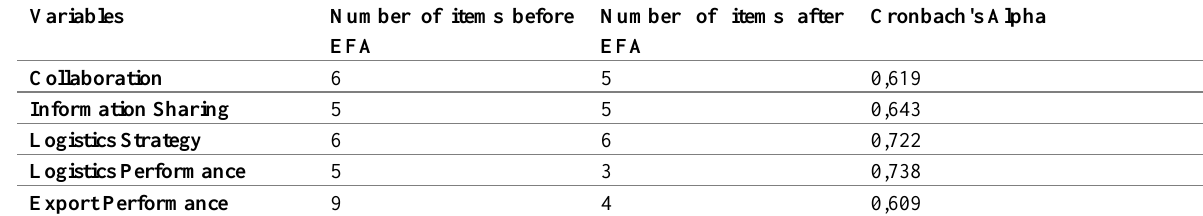
Table 3: Summary of the results of the principal component